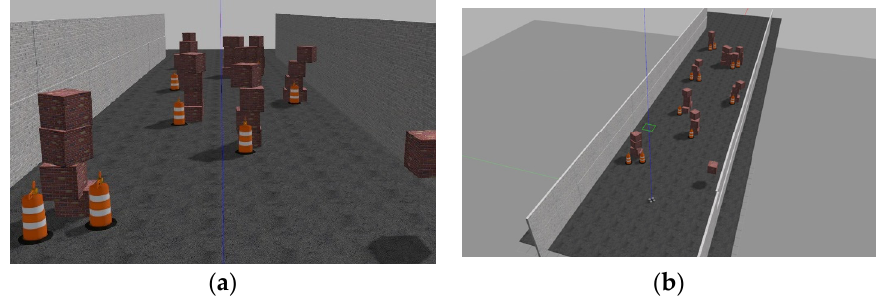
Figure 12. The Basic Training Environments for Our Framework in Gazebo. ( a ) Front view, ( b ) Top view.